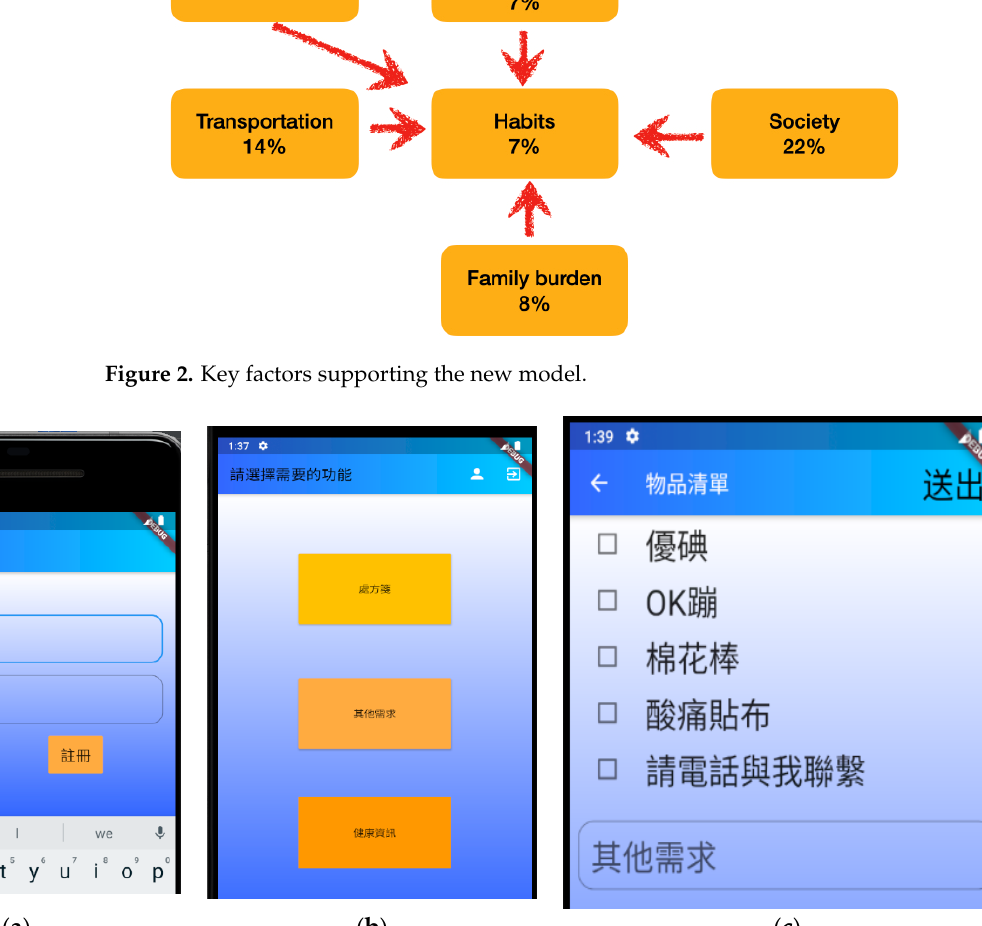
Figure 3. Main interface and functions design in traditional Chinese character. ( a ) is registration and login in screen by key in phone number; ( b ) is function selection, three large buttons provide medicine, daily necessities, and health consultation respectively; ( c ) provide items selection without input